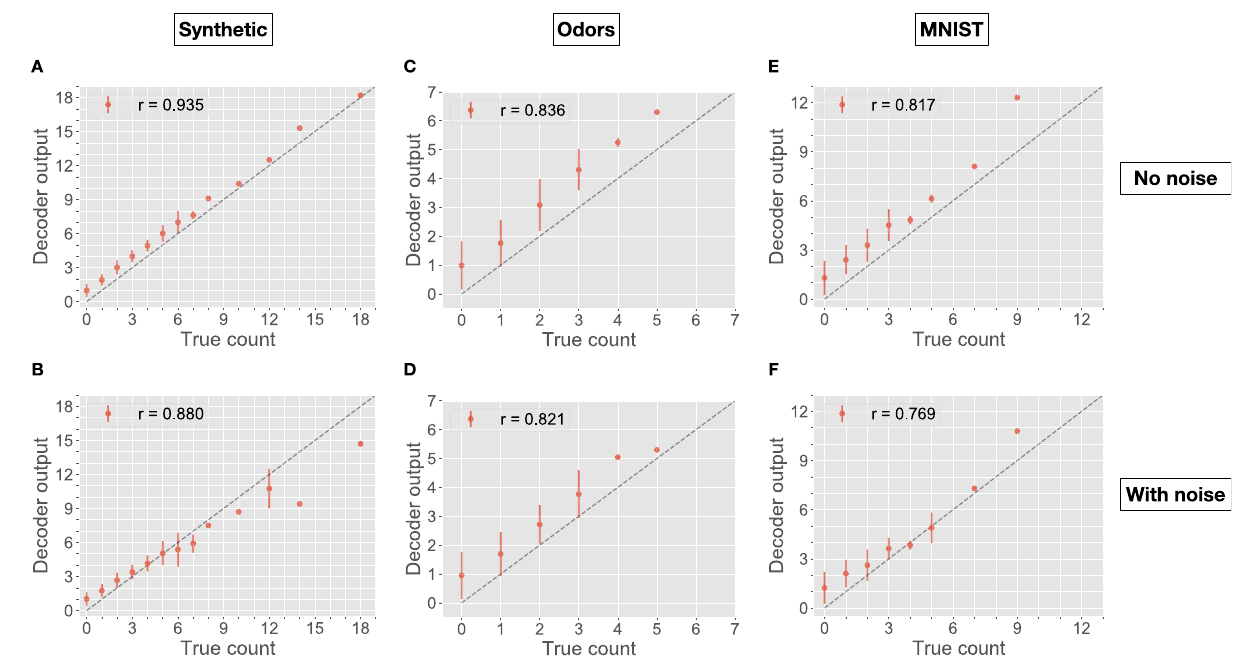
Fig. 2 | Performanceoftheneuralcount sketch(Hebbianmodel). In eachpanel, the x -axisshowstheground-truthcount, and the y -axisshowsthepredictedcount, as outputted from the decoder neuron. Dots show average decoder responses for items of the same ground-truth count, and error bars indicate standard deviation. Perfect performance would lie on the dotted y = x line. Pearson correlation